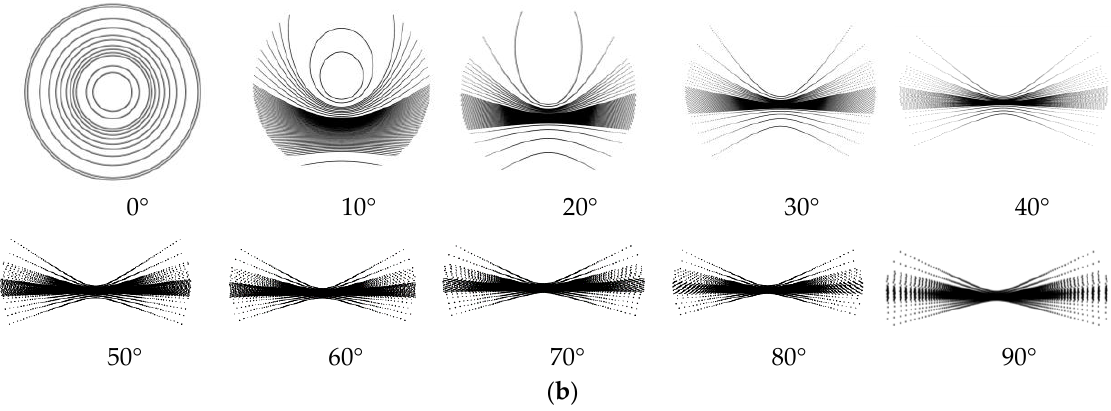
Figure 8. Stationary scanning patterns at a scanning range of 20 m on the ground. ( a ) OS-1-64. ( b )